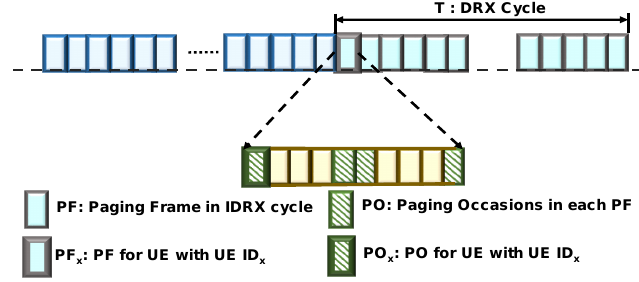
Figure 2. Paging frame (PF) and paging occasion (PO) in a legacy